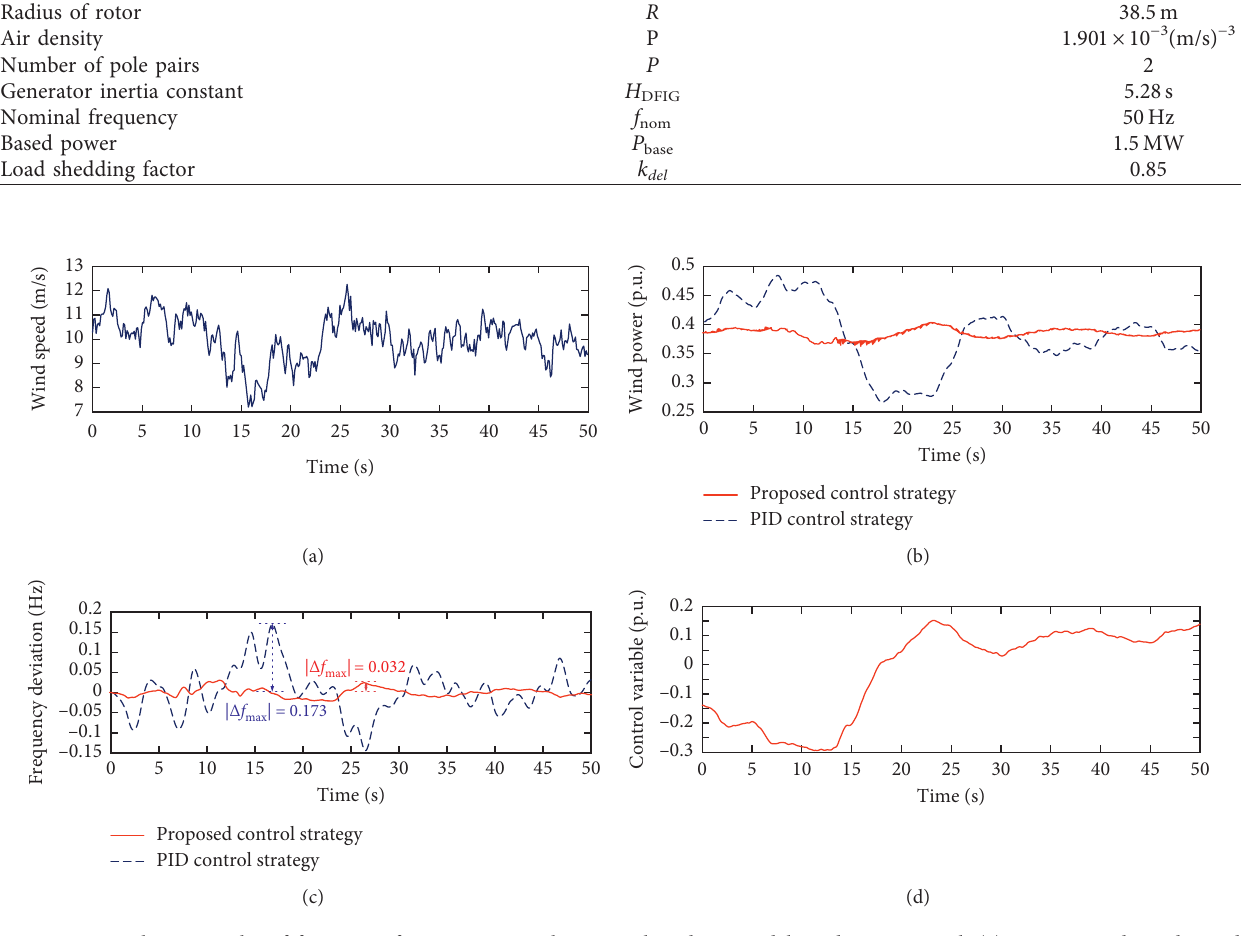
Figure 7: Simulation results of fan active frequency control strategy based on model predictive control. (a) A 50-second wind speed sequence. (b) Wind power output of wind turbine. (c) System frequency deviation. (d) Fan output power command, i.e., control Table 3: Comparison of single region simulation results.